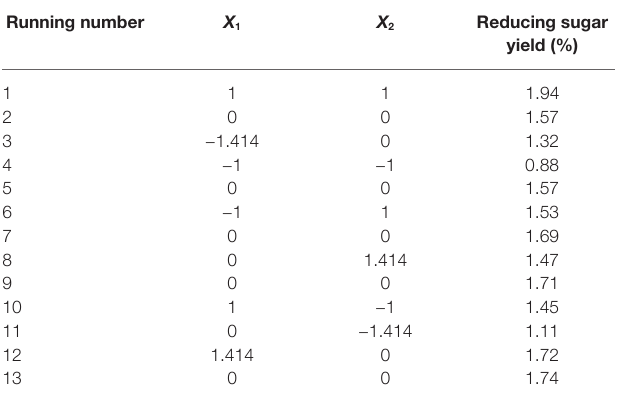
TABLE 4 | Experimental design and results of CCD. Running number X 1 X